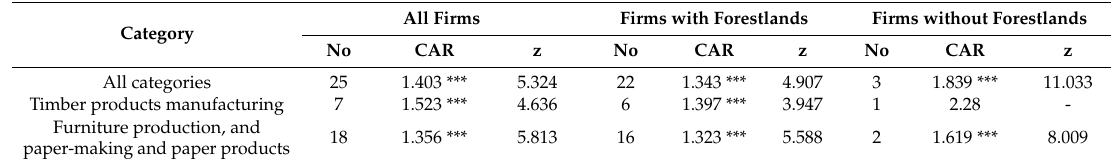
Table 3. Results of testing policy II.